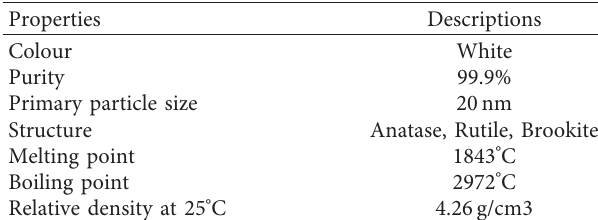
Table 1: Properties of nano TiO